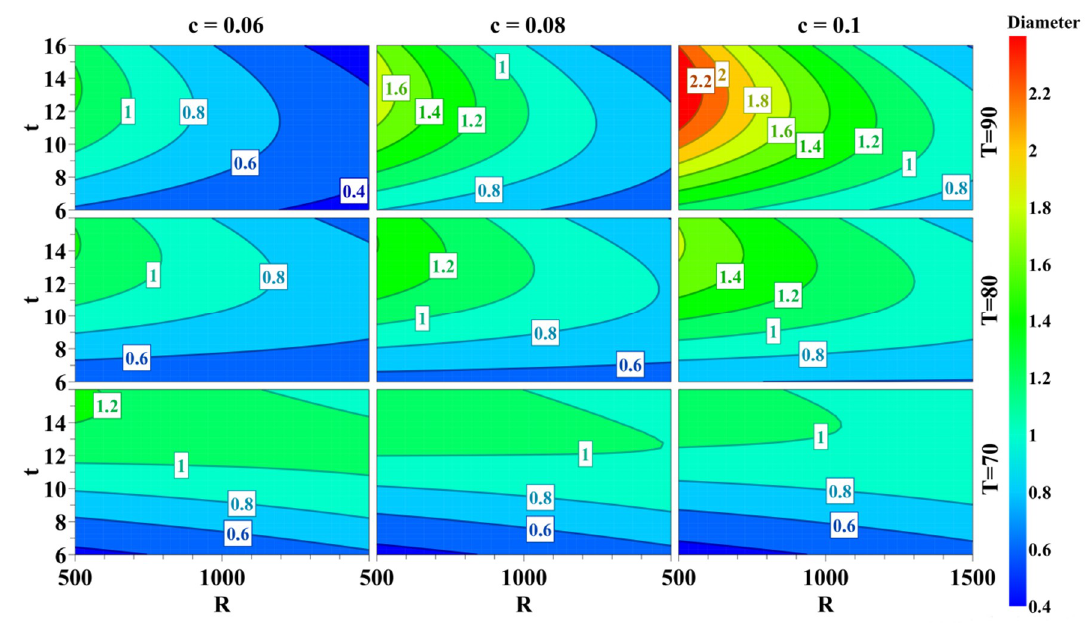
Figure 5. The response 4D contour plot of the diameters. The three columns of images represent the changing tendency of diameter with varied reaction temperatures and molar ratios of Zn 2+ to tri-sodium citrate when c = 0.06, 0.08, and 0.1 M, and the three rows of images represent the changing tendency of diameter with varied reaction temperatures and molar ratios of Zn 2+ to tri-sodium citrate when T = 70, 80, and 90 °C.